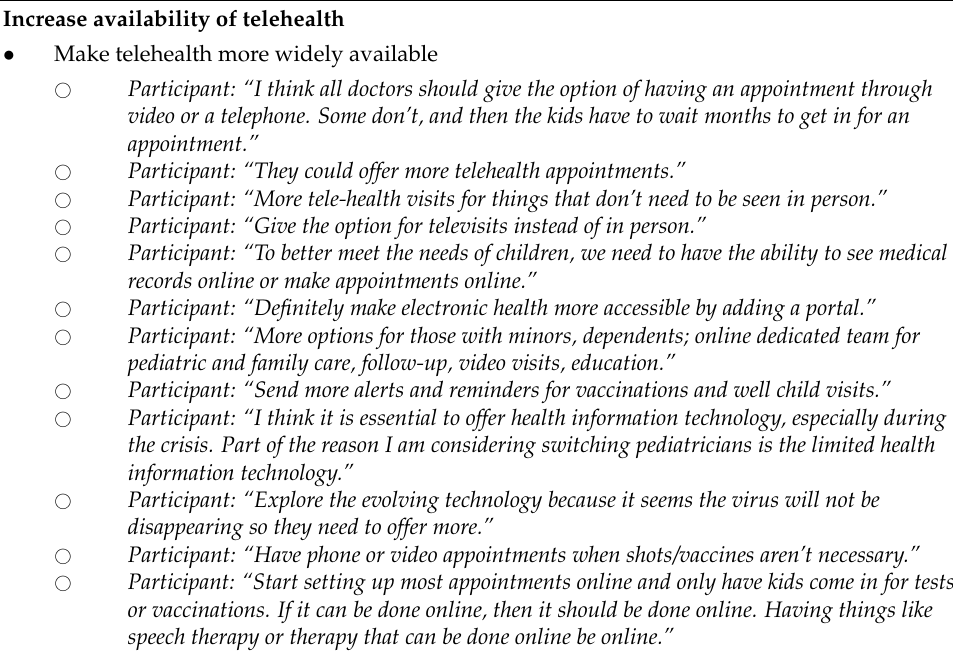
Table 4. Suggestions for increasing availability of and access to telehealth along with representative quotes by the